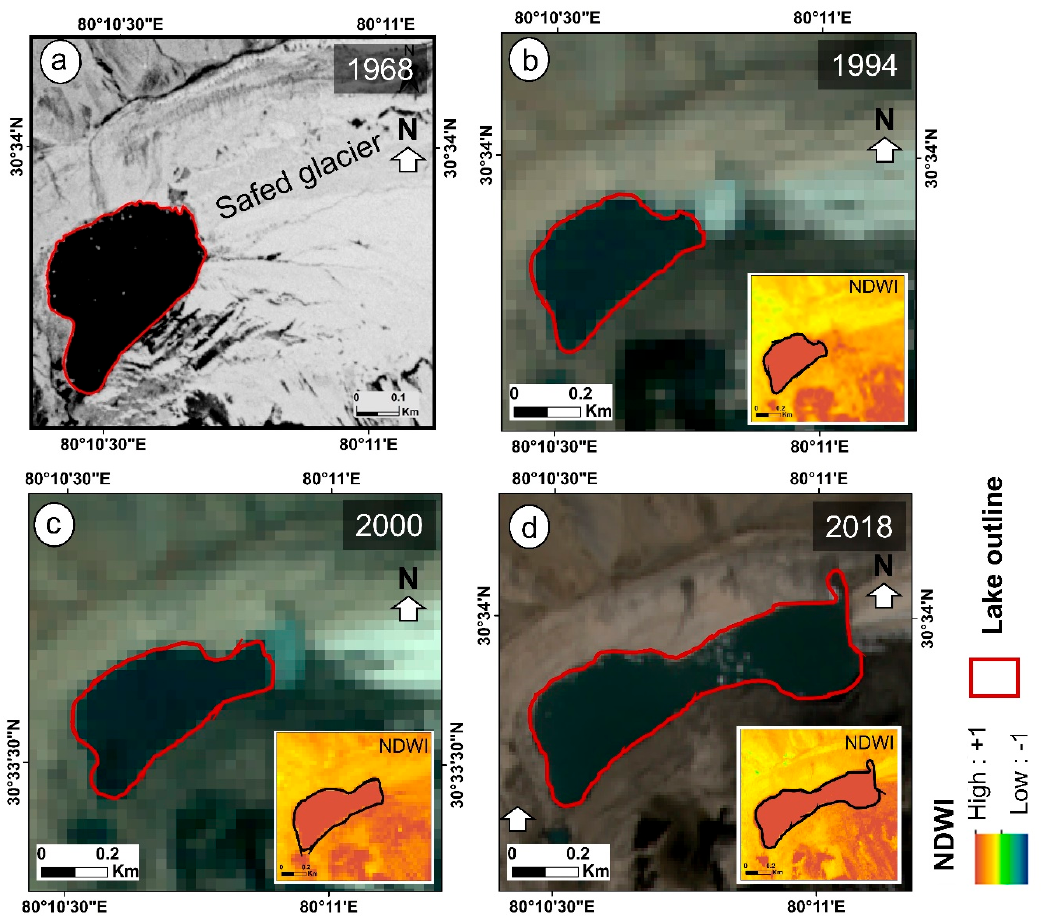
Figure 4. The growth of Safed Lake from 1968 to 2018 ( a – d ); the subset image (in b – d ) shows the Normalized Differential Water Index (NDWI) for the respective years.